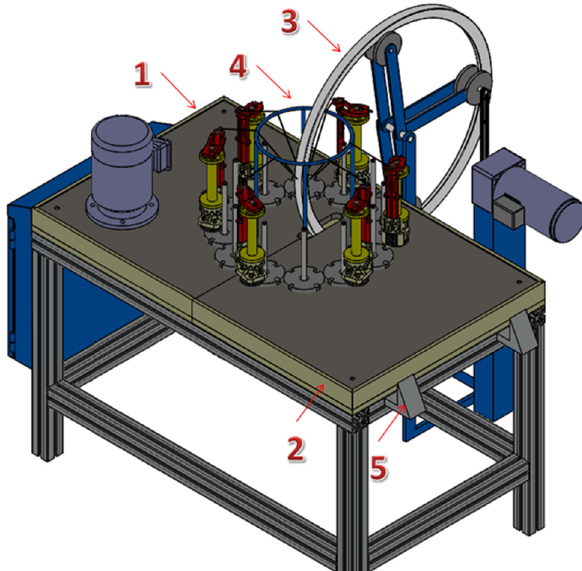
Figure 1: Schematic diagram of the annular axis braiding machine ( 1: fi xed plate, 2: movable plate, 3: mandrel, 4: braiding ring, and 5: stop block )